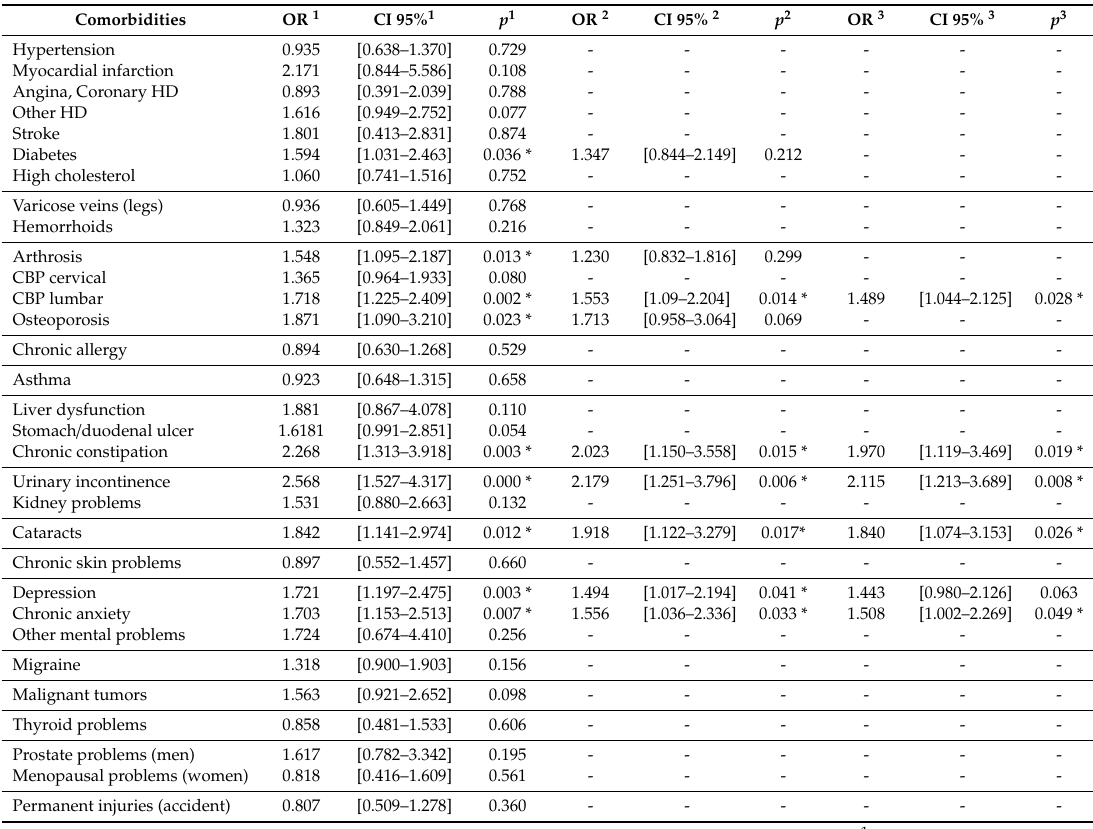
Table 3. Association of physical activity (PA) and chronic obstructive pulmonary disease (COPD) comorbidities (outcome) estimated by multivariable logistic